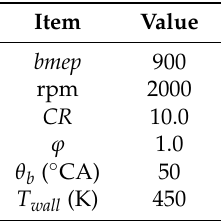
Table 3. Description of Case